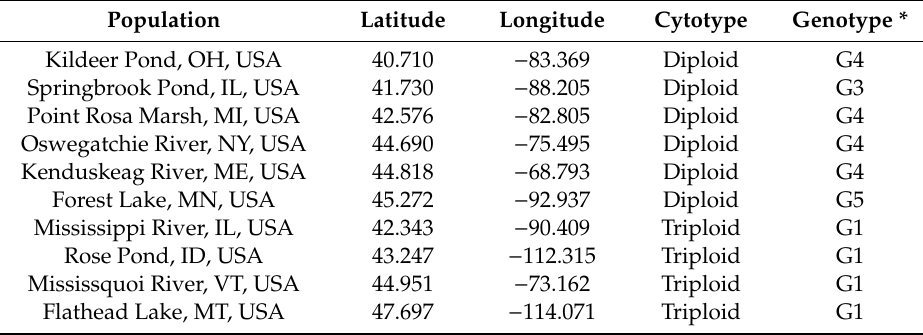
Table 1. Populations used to test for di ff erences between cytotypes in invasiveness under submersed or emergent